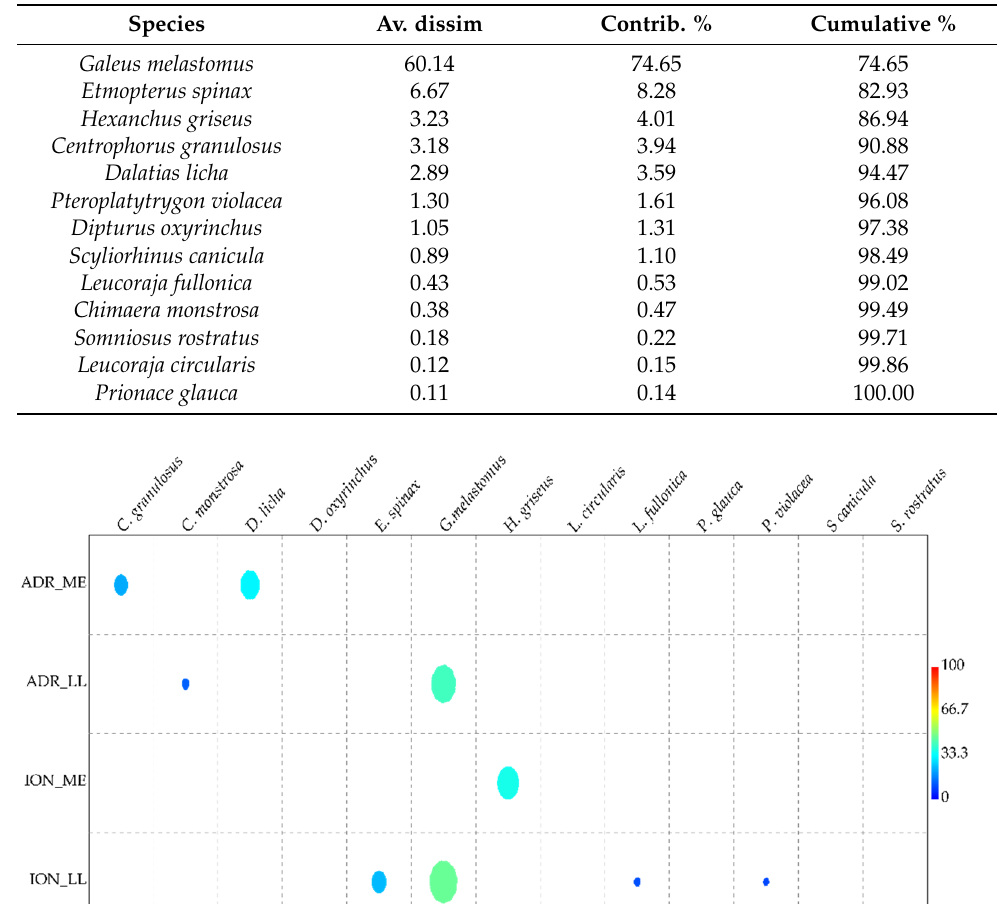
Table 5. Results of similarity percentages analysis (SIMPER) of the differences in species composition between areas and sampling tools.